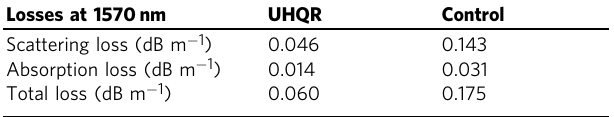
Table 1 Contribution from different loss